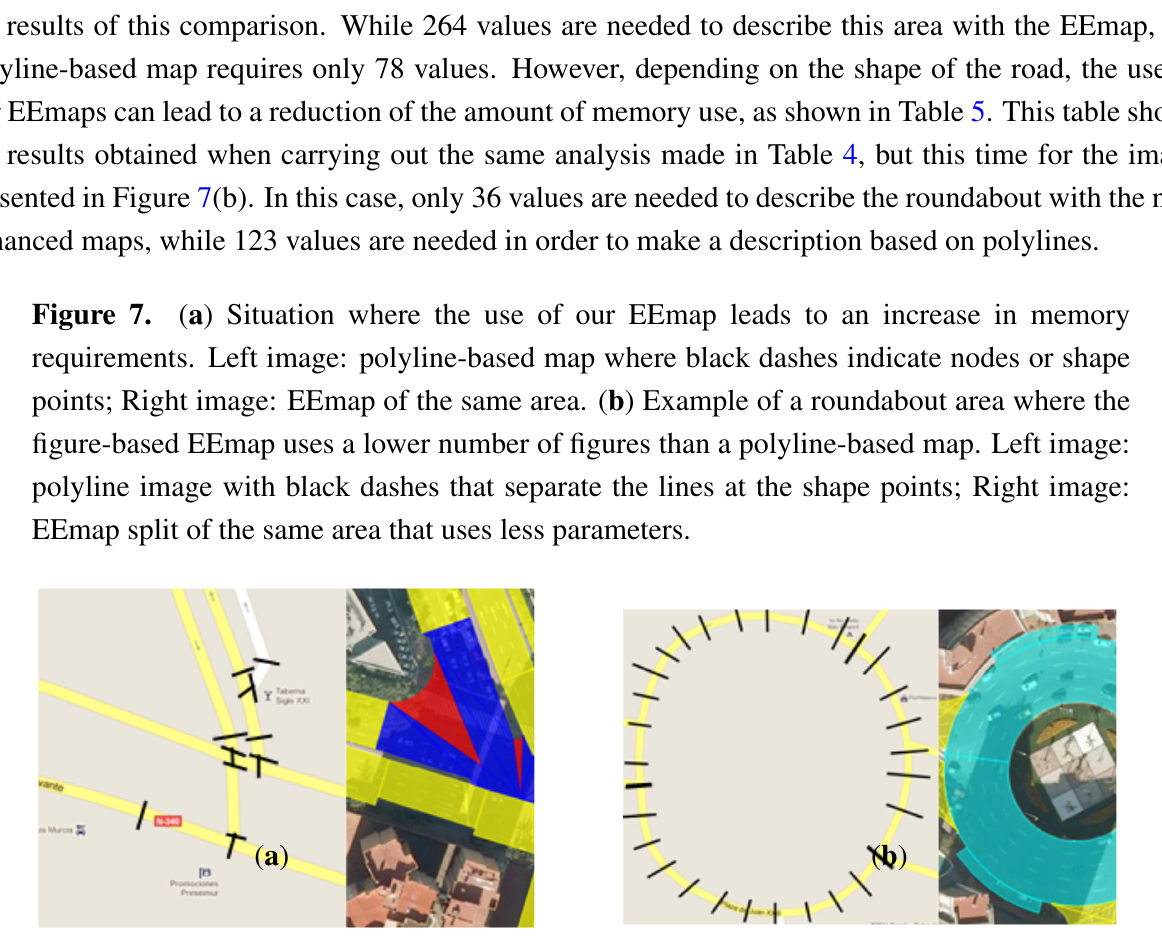
Table 4. Comparison of the number of parameters needed to describe the image shown in Figure 7(a) with a polyline-based map and our